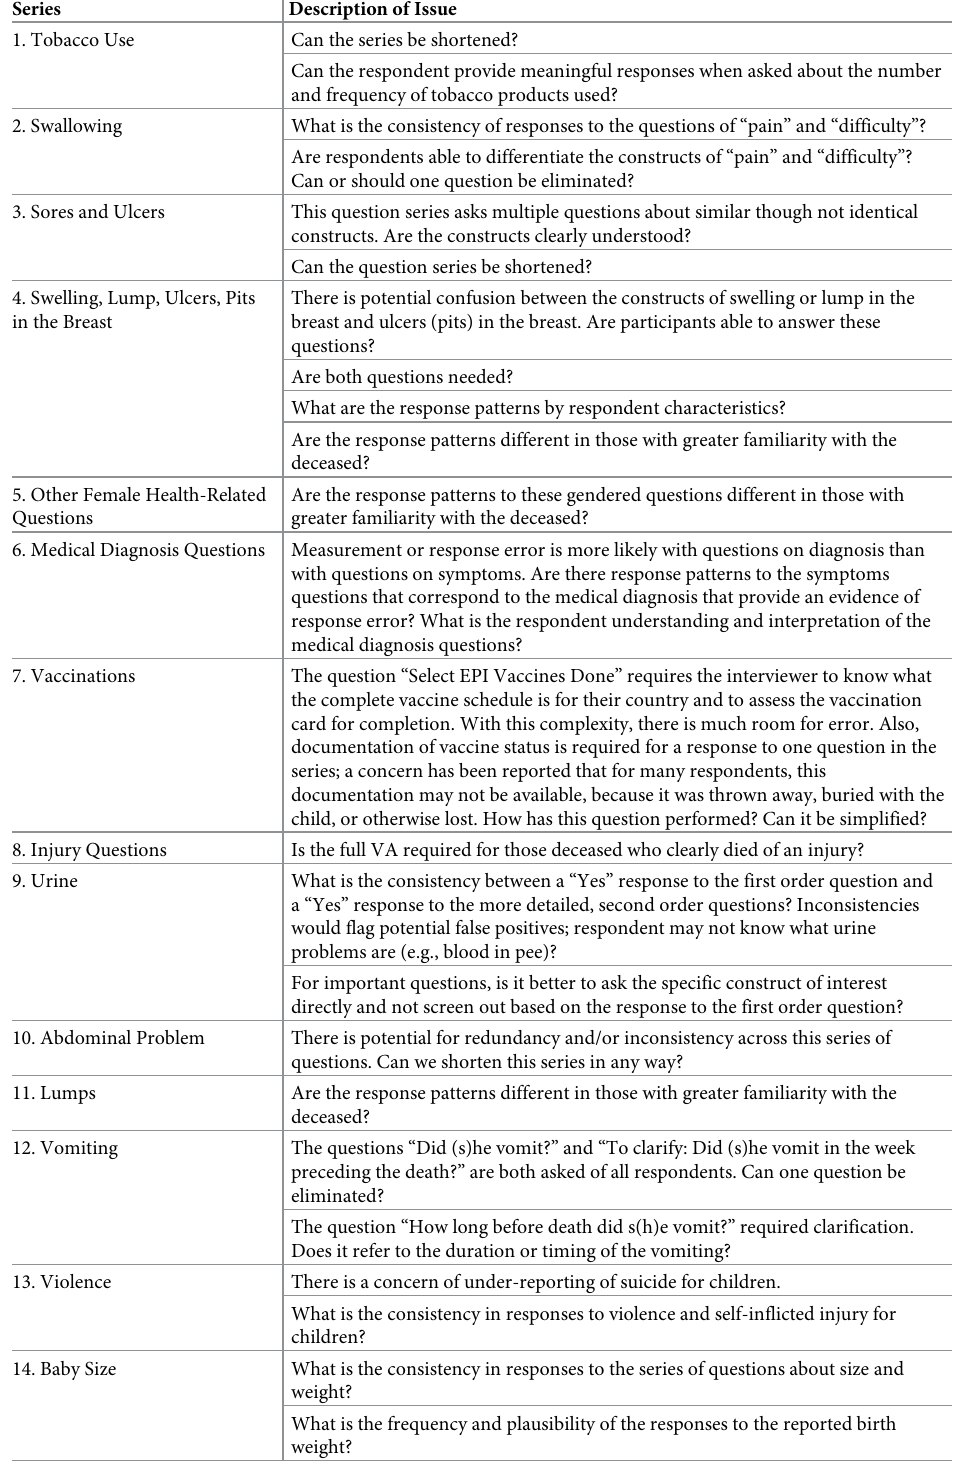
Table 1. Series of questions identified for review from feedback from field teams and description of associated